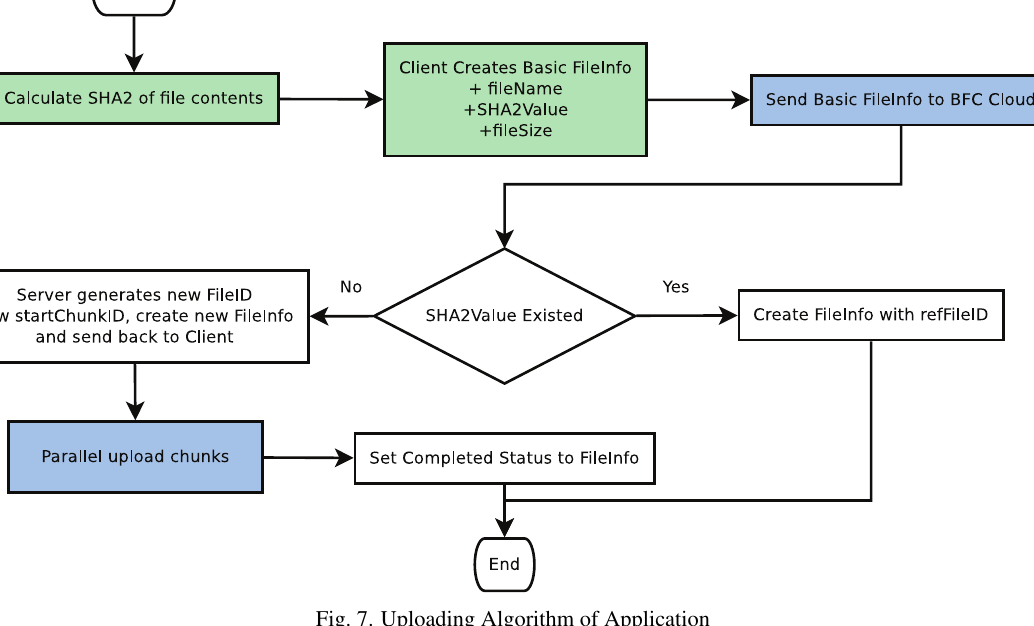
Fig. 7. Uploading Algorithm of Application